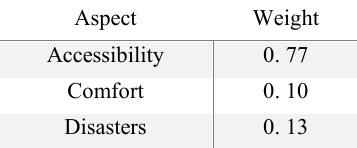
Table 3 . Weight of each